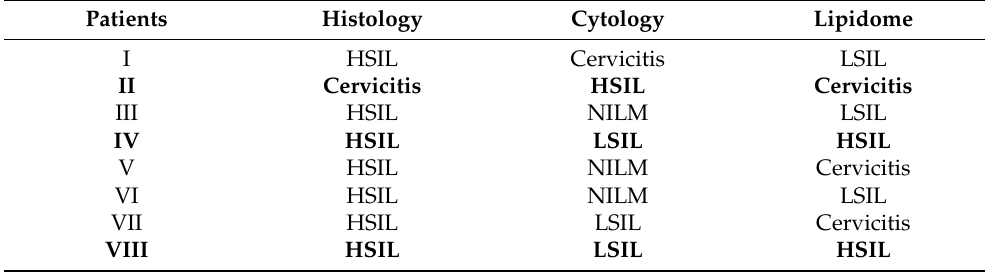
Table 4. Comparison of lipidome, cytological and histological analysis of several patients. Bold type indicates patients for whom histology and lipidomic diagnosis